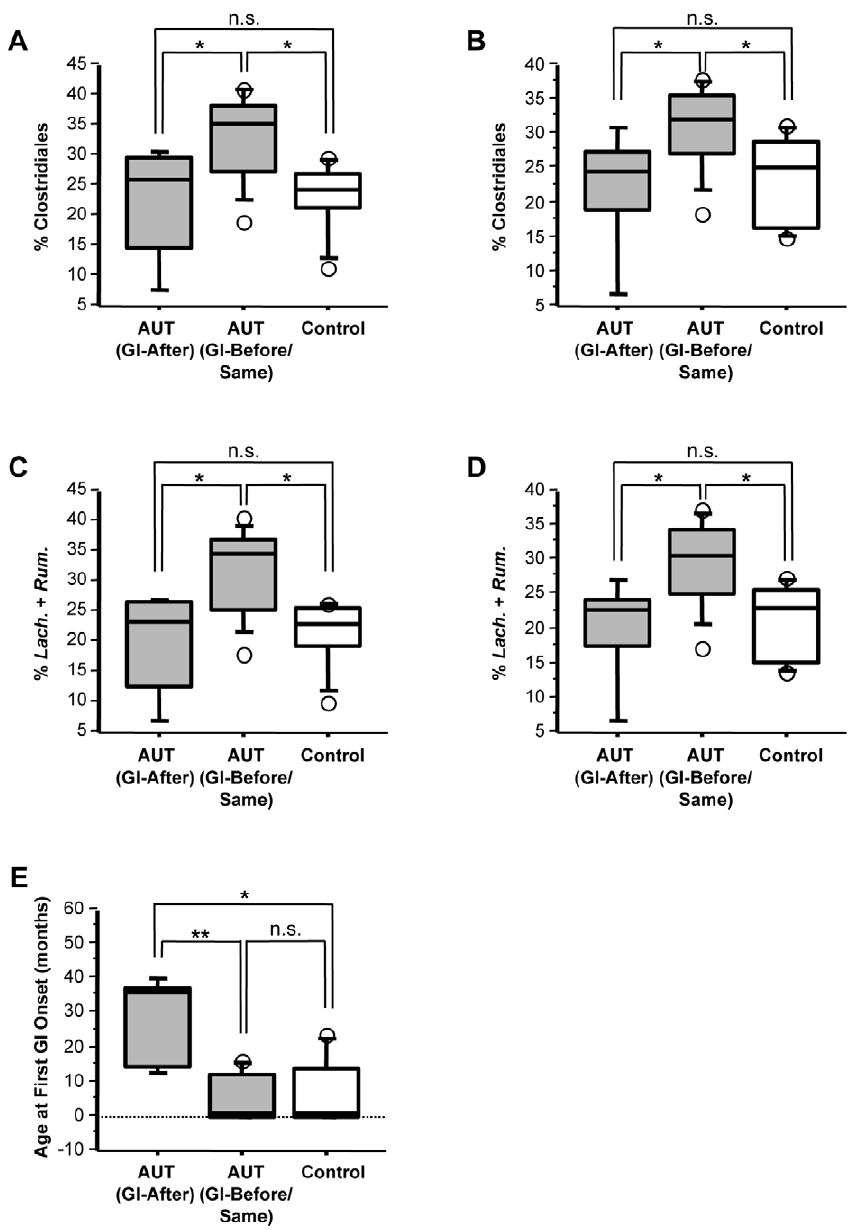
Figure 6. Levels of Clostridiales members in AUT-GI patients stratified by timing of GI onset. ( A–B ) Abundance of Clostridiales from ileal ( A ) and cecal ( B ) biopsies from AUT-GI and Control-GI patients (n=7), with AUT-GI stratified by whether the onset of GI symptoms occurred after (n=5) the onset of autism symptoms (GI-After) or before and at the same time (n=10) as autism symptoms (GI-Before/Same). [ A : AUT (GI-After) vs. AUT (GI-Before/Same), Mann-Whitney, p=0.028; AUT (GI-Before/Same) vs. Control-GI, Mann-Whitney, p=0.015; AUT (GI-After) vs. Control-GI, Mann- Whitney, p=0.935] [ B : AUT (GI-After) vs. AUT (GI-Before/Same), Mann-Whitney, p=0.037; AUT (GI-Before/Same) vs. Control-GI, Mann-Whitney, p=0.019; AUT (GI-After) vs. Control-GI, Mann-Whitney, p=0.935]. ( C–D ) Cumulative abundance of Lachnospiraceae and Ruminococcaceae from ileal ( C ) and cecal ( D ) biopsies from AUT-GI and Control-GI patients (n=7), with AUT-GI stratified by whether the onset of GI symptoms occurred after (n=5) the onset of autism symptoms or before and at the same time (n=10) as autism symptoms [ C : AUT (GI-After) vs. AUT (GI-Before/Same), Mann- Whitney, p=0.028; AUT (GI-Before/Same) vs. Control-GI, Mann-Whitney, p=0.015; AUT (GI-After) vs. Control-GI, Mann-Whitney, p=0.808] [ D : AUT (GI-After) vs. AUT (GI-Before/Same), Mann-Whitney, p=0.020; AUT (GI-Before/Same) vs. Control-GI, Mann-Whitney, p=0.011; AUT (GI-After) vs. Control-GI, Mann-Whitney, p=0.685]. ( E ) Age at GI onset (in months) for AUT-GI and Control-GI patients, with AUT-GI stratified by whether GI onset occurred after (n=5) the onset of autism symptoms or before and at the same time (n=10) as autism symptoms [ E : AUT (GI-After) vs. AUT (GI-Before/ Same), Mann-Whitney, tied p=0.007; AUT (GI-Before/Same) vs. Control-GI, Mann-Whitney, tied p=0.757; AUT (GI-After) vs. Control-GI, Mann-Whitney, tied p=0.027]. *, p , 0.05; **, p , 0.01; n.s., not significant.